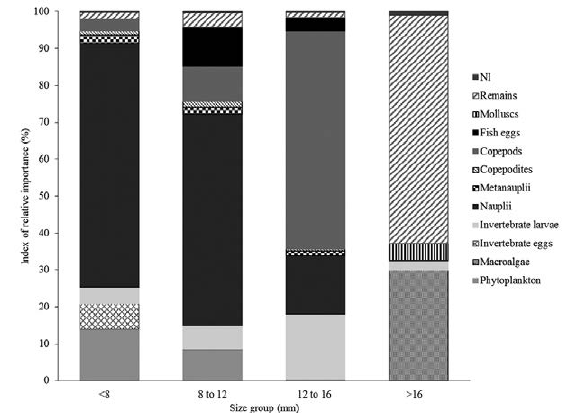
Fig. 5. – Percentage of index of relative importance (%IRI) of prey ingested by S. sanguineus during early ontogenetic development, according to size group (NI is non-identified prey).